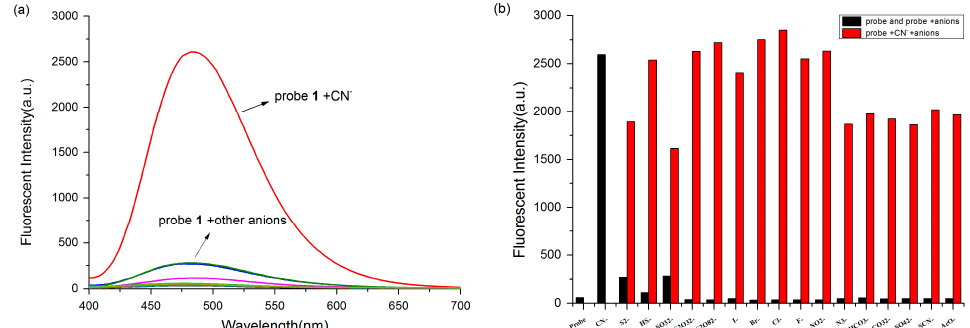
Figure 1. ( a ) Fluorescent responses of probe 1 (5 µM) towards various anions (50 µM) in PBS/DMSO (4/6, pH = 7.4) solution. λ ex = 370 nm, Slits: 2.5 nm/5 nm; ( b ) Competing responses of probe 1 (5 µM)